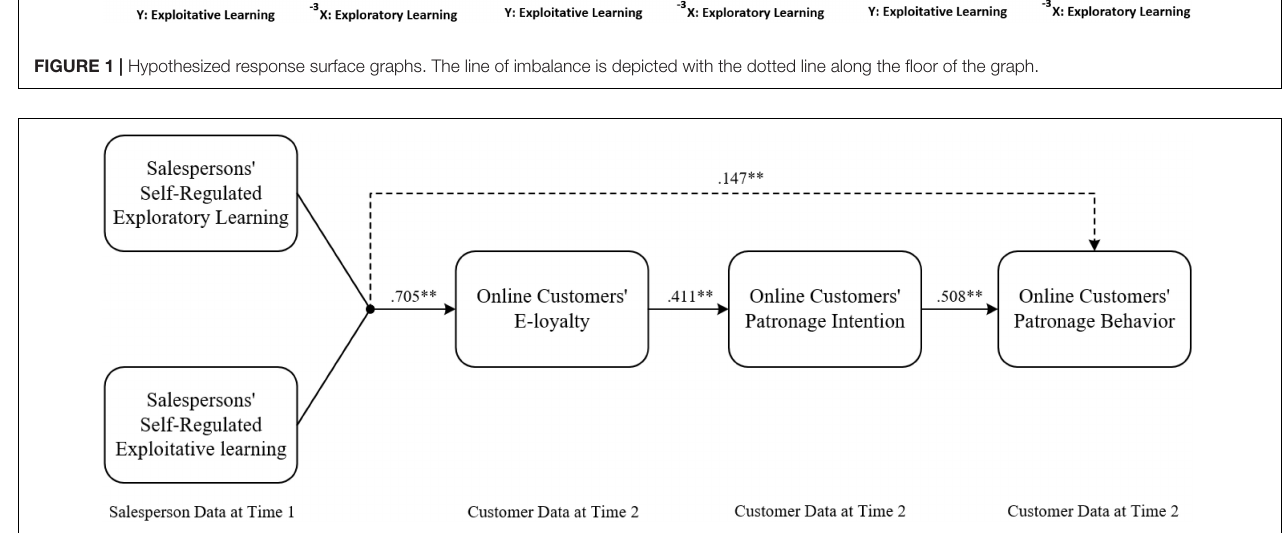
FIGURE 2 | Hypothesized model for the current study and estimated standardized coefficients. → represents indirect paths via e-loyalty and patronage intention. → represents direct paths. ∗ p < 0.05, ∗∗ p <